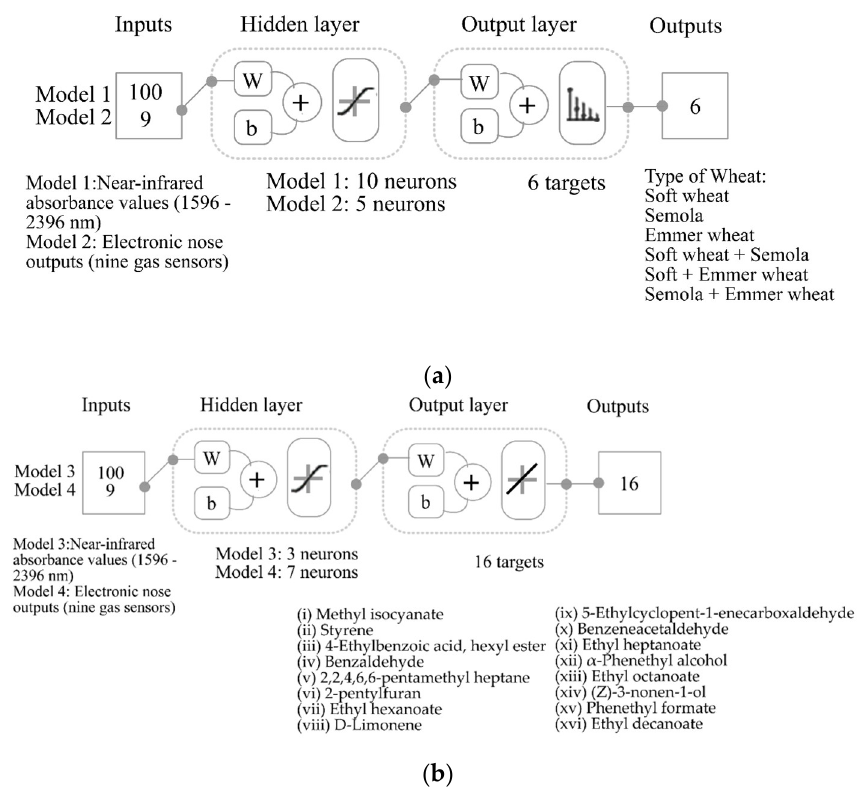
Figure 3. Diagrams of the machine learning ( a ) classification Models 1 and 2 and ( b ) regression Models 3 and 4 showing the specific inputs, targets, and number of neurons used. Abbreviations: W: weights; b: